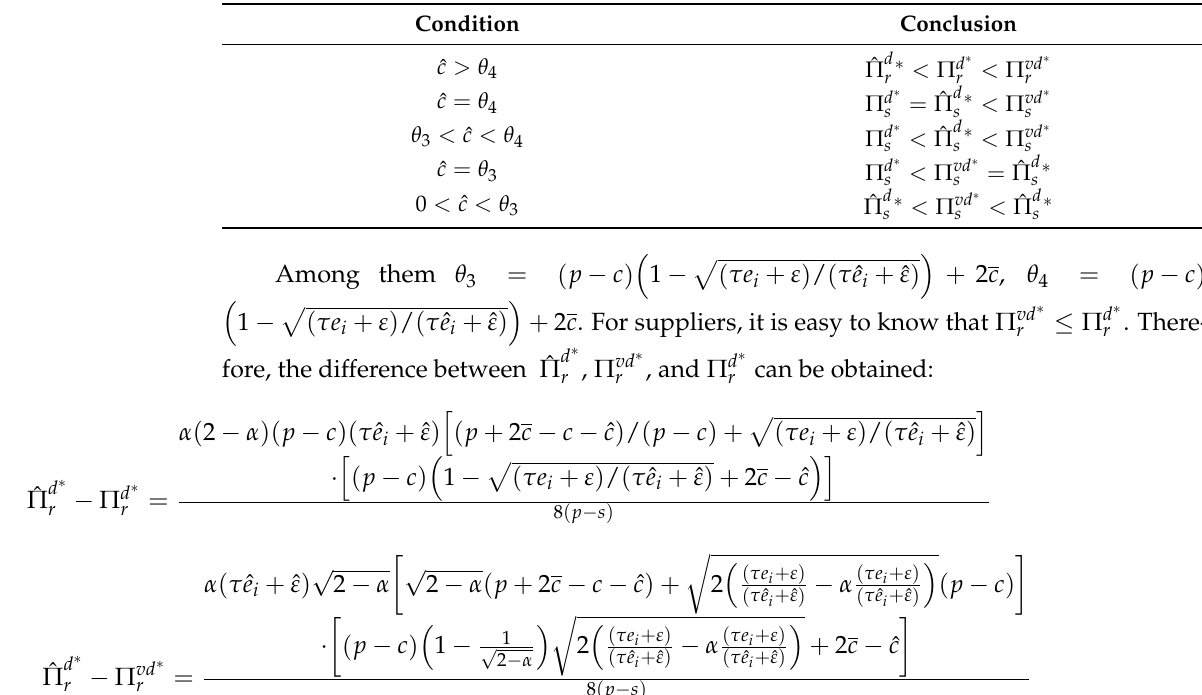
Table 3. Comparison of retailers’ income under Stackelberg